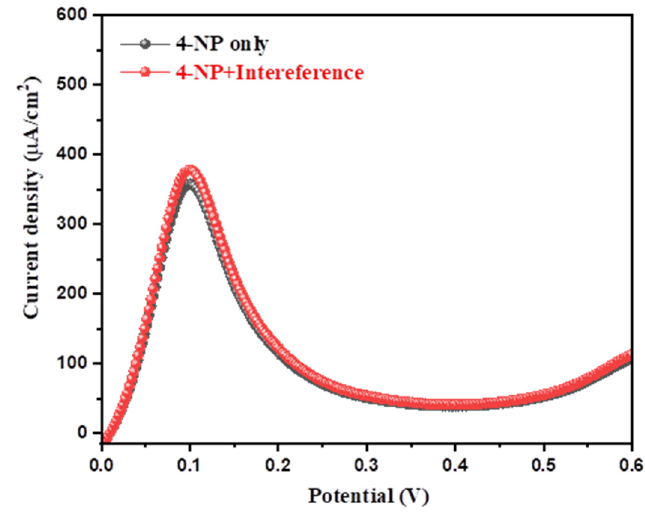
Figure 8. LSV of MnO 2 /rGO/GCE in 50 µ M 4-NP and 50 µ M 4-NP + 200 µ M interference species (urea, uric acid, glucose, dopamine, catechol, ascorbic acid, hydroquinone, hydrazine, and H 2 O 2 ) (scan rate = 50 mV/s).